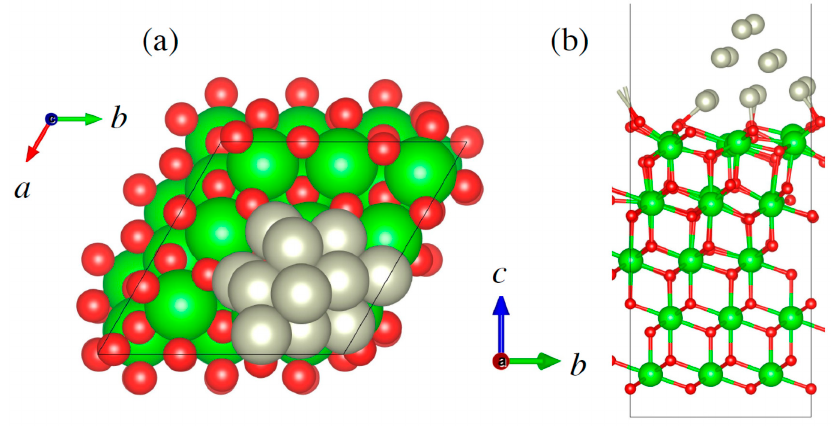
Figure 13. A Rh 12 cluster bound to a flat oxygen-terminated surface, which was structurally relaxed by DFT calculations. The large green spheres represent Zr atoms, the small red spheres represent oxygen atoms, and the gray spheres represent Rh atoms. ( a ) is the top view and ( b ) is the side view.